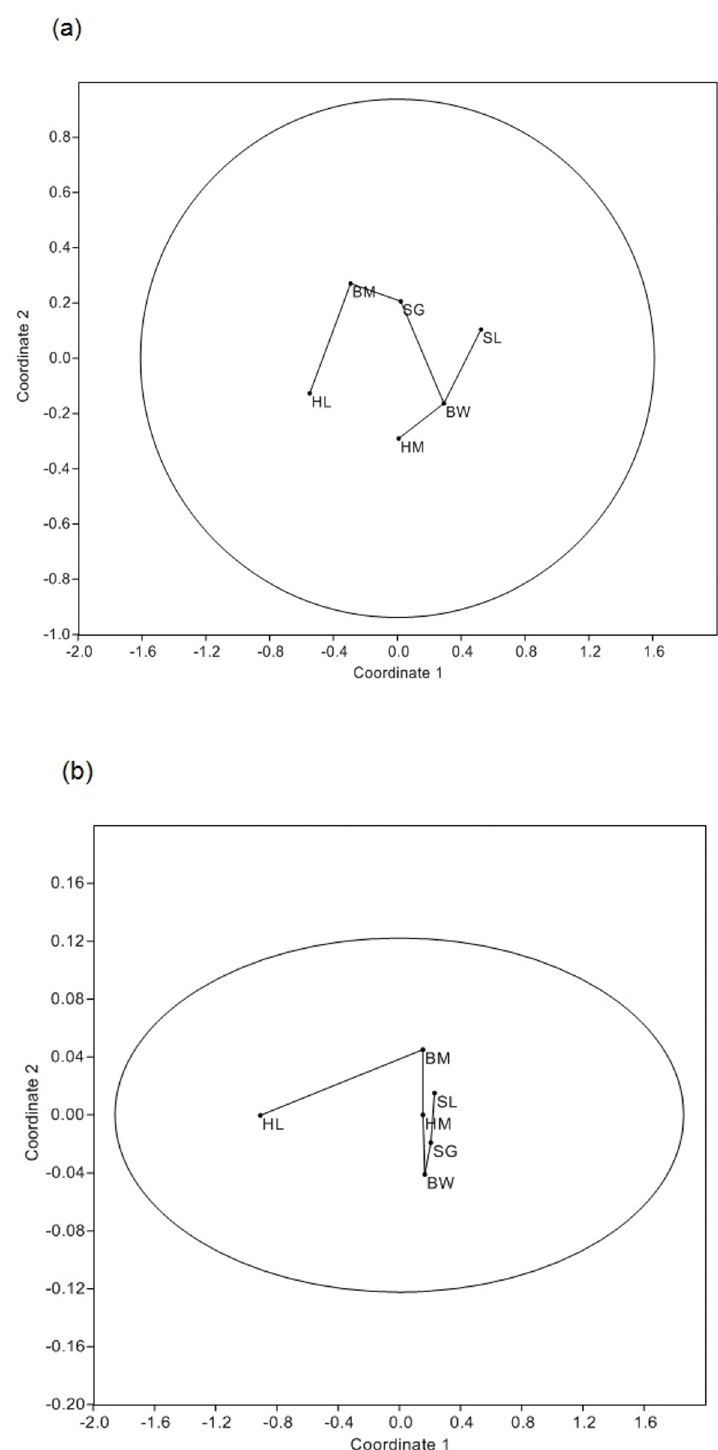
Fig 3. The gradient of net yield outcomes for open (a) and exclusion (b) treatments across orchards did not match the gradient of management intensity. NMDS ordination includes 95% ellipses. N.B. The gradient of orchard management intensity from least to most intensive is: HM, SG, BM, BW, HL, SL (S1 and S3 Tables).